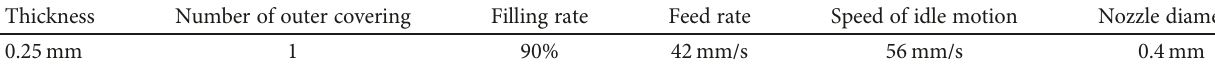
Table 6: Print parameter settings.